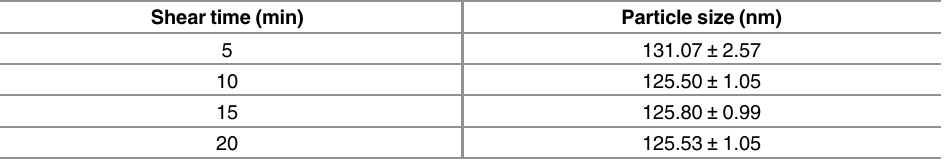
Table 2. Particle size (nm) of nanoemulsion at different shear time